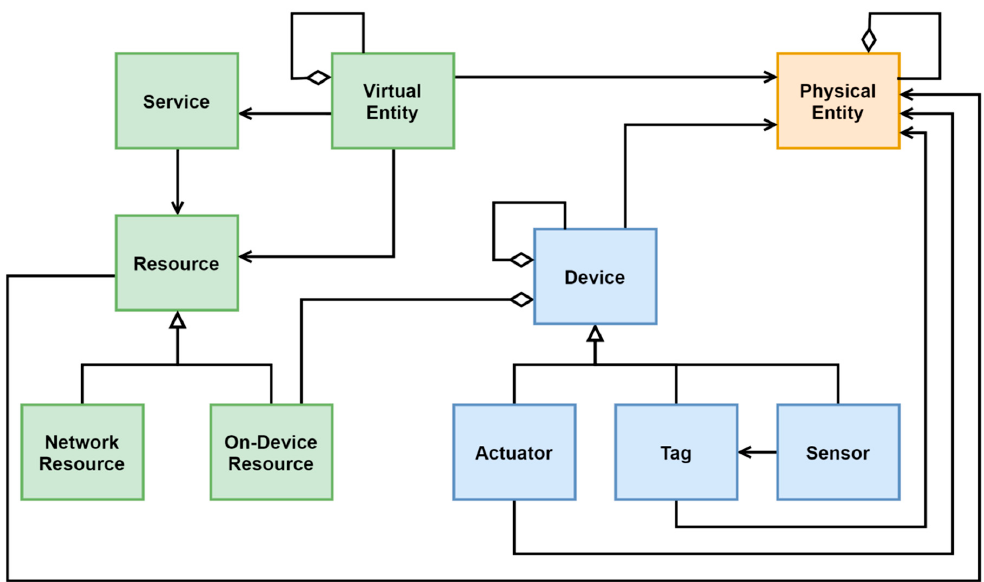
Figure 6. IoT-A domain model restricted to the virtual representation of a physical entity [44].